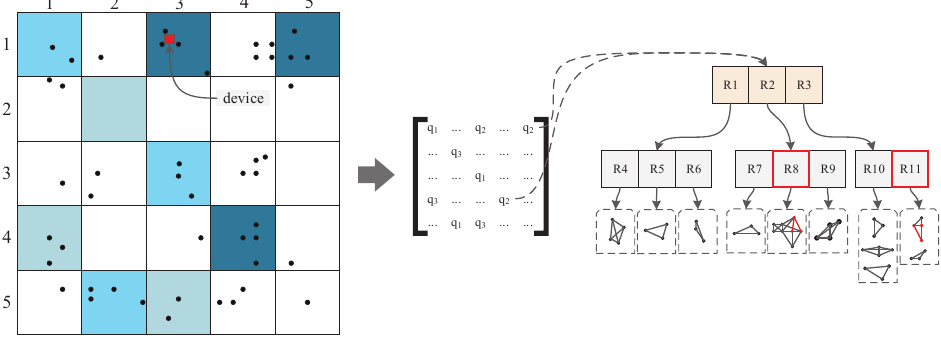
Figure 4. Noise data set concerning the query probability.